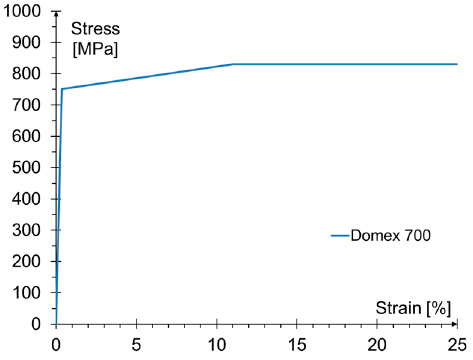
Figure 13. Material model of the